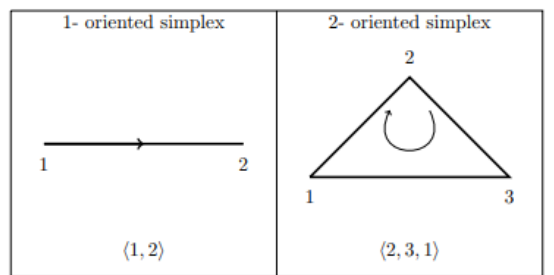
Figure 10. Oriented 1-simplex and